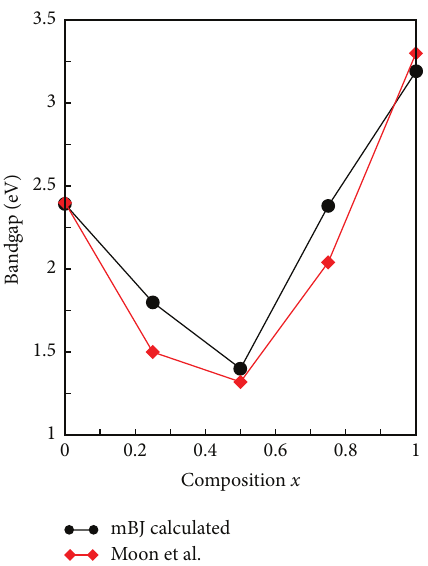
Figure 3: Bandgap energy as function of composition 𝑥 .